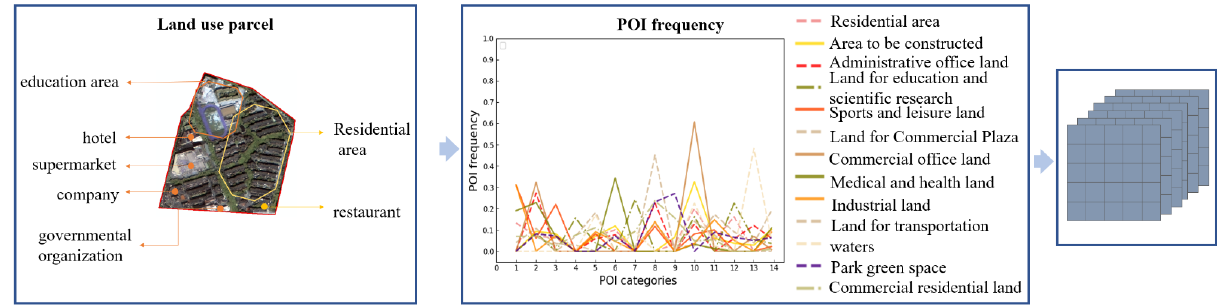
Figure 7. Generation of the footprint feature tensor.